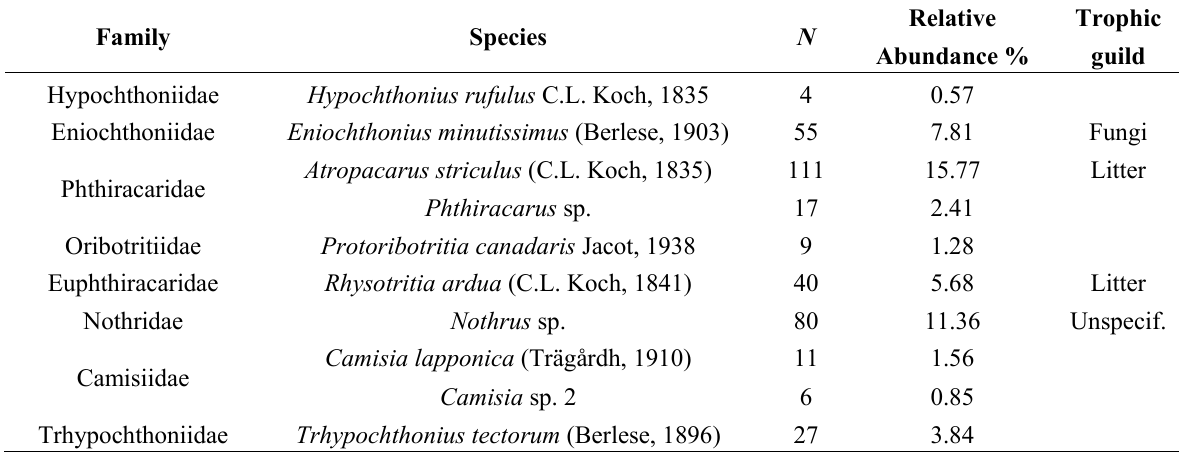
Table A1. Number of individuals and relative abundance of the 39 Oribatid species found and trophic guild of the 8 most abundant